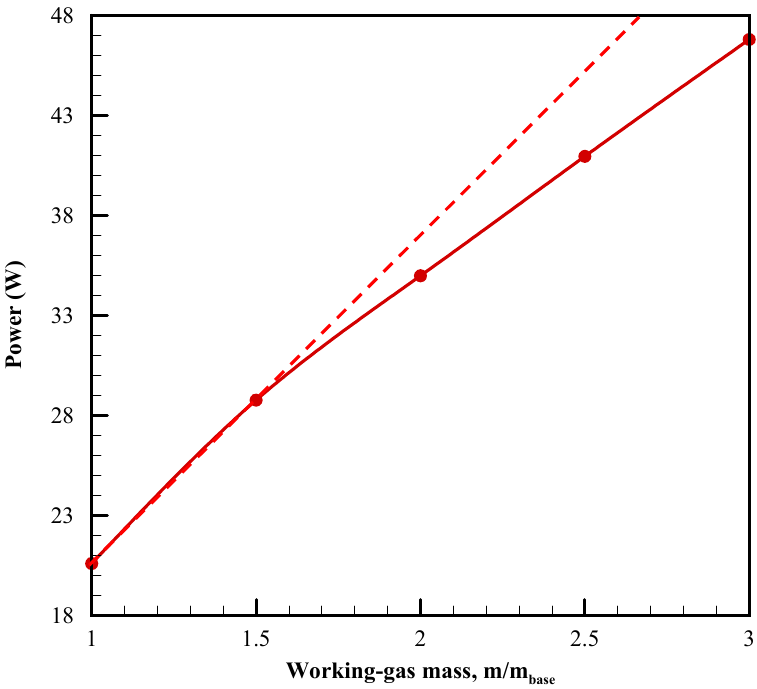
Figure 10. Variation of the engine power with the working gas mass.